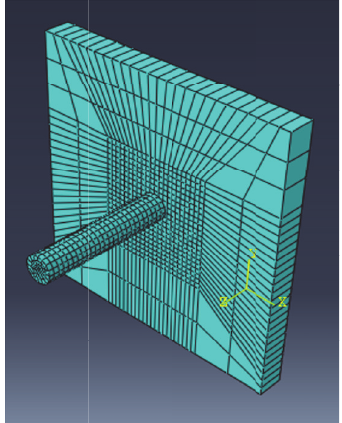
Figure 3: FEA model for the Al-Al